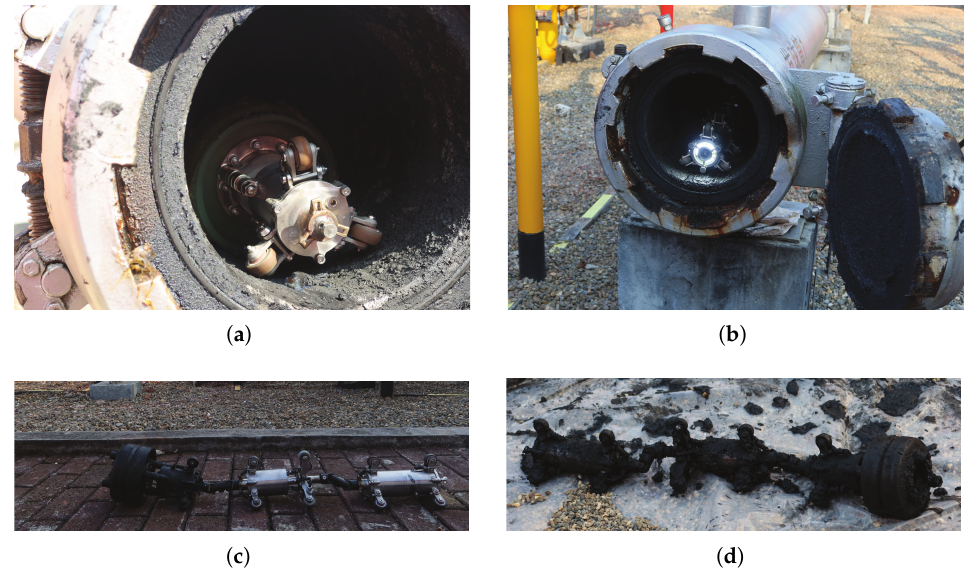
Figure 19. Comparison of the traction unit and prototype before and after testing. ( a ) Traction unit in the pig launcher before passing through the pipeline; ( b ) prototype in the launcher before passing through the pipeline; ( c ) traction unit after passing through the pipeline; ( d ); prototype after passing through the